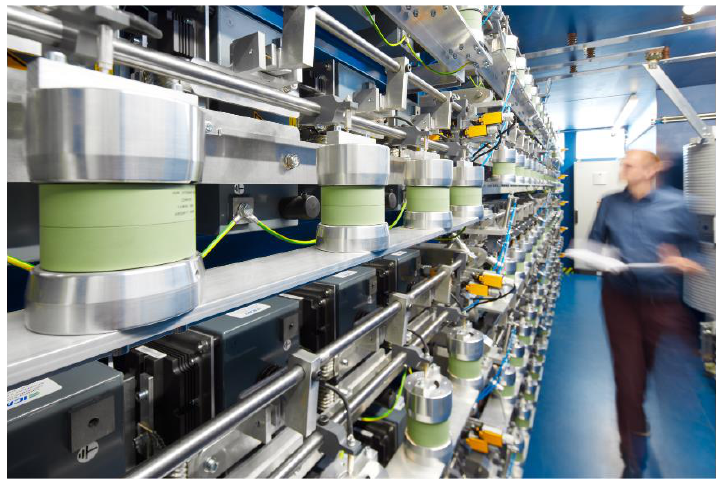
Figure 8. Photo of the demonstrator high-power test circuit with capacitor banks containing indi- vidual PEBC modules (left) and control inductance (right). The device under test ( DuT ) is placed in a spatially separate area for reasons of personnel and system safety.